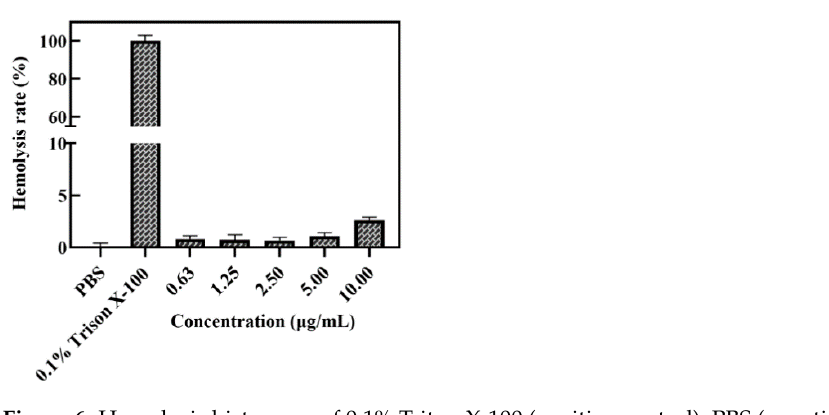
Figure 7. In vitro fluorescence imaging of HepG2 cells after treatment with A-BG-DOX and free DOX in their culture medium at pH 6.5 and 7.4; scar bar is 36.8 µm. To study the percentage of apoptotic and necrotic cells induced by A-BG-DOX at pH 6.5, we performed apoptosis assays on treated HepG2 cells using flow cytometry. The total cells were divided into four populations including normal cells (annexin V-/PI- , Q1), early apoptotic cells (annexin V+/PI-, Q2), late apoptotic cells (annexin V+/PI+, Q3), and necrotic cells (annexin V-/PI+, Q4). Treatment with 0.5 µg/mL of A-BG-DOX left